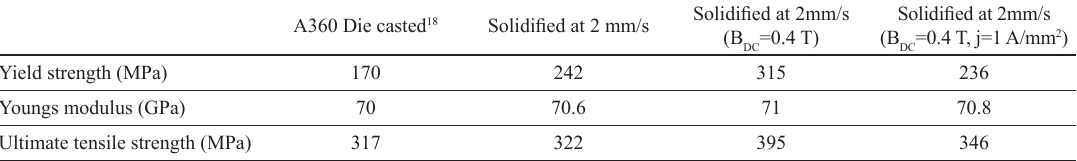
Table 2. Comparison of mechanical properties between A360 alloy ingots solidified in various